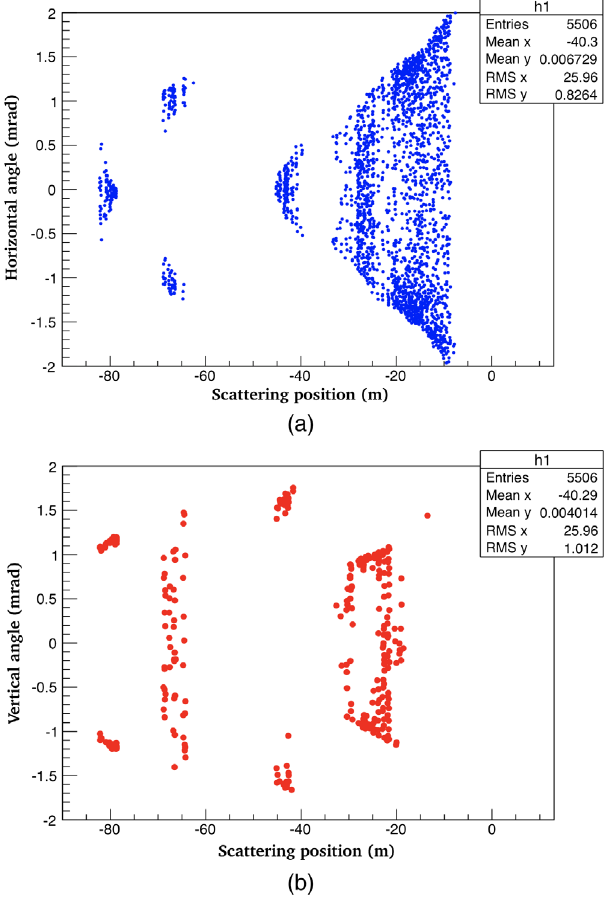
FIG. 10. (a) The horizontal exiting angles and (b) the vertical exiting angles of the lost Coulomb scattered positrons in the drift where we place our